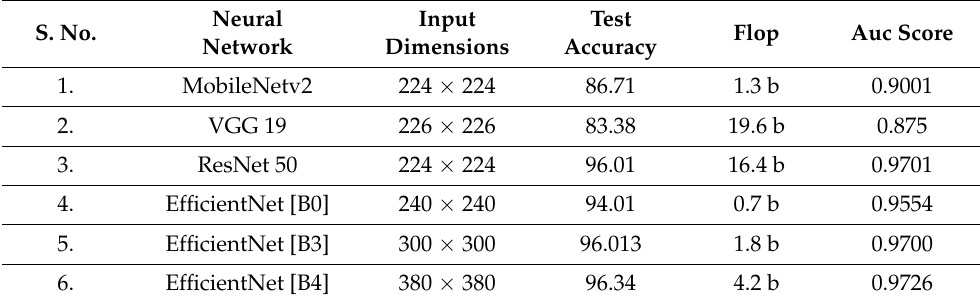
Table 5. Analysis of performance measures for different deep learning